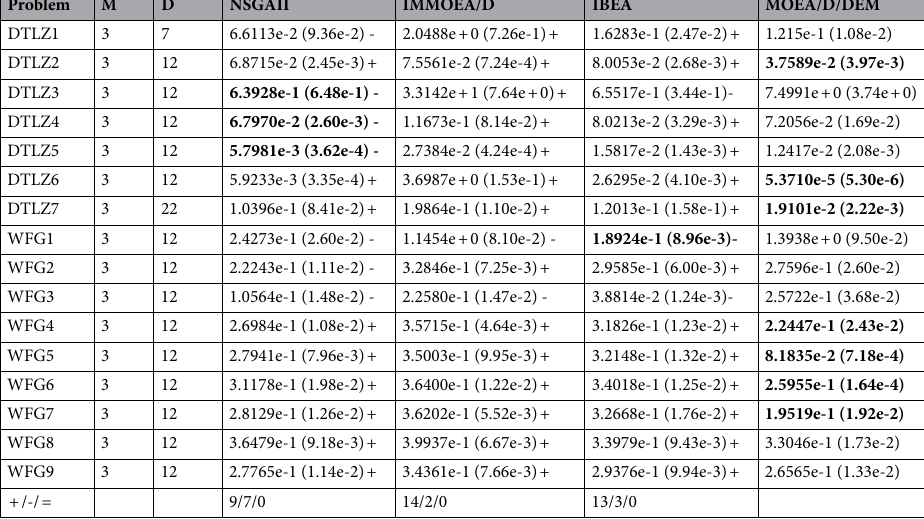
Table 2. IGD values of 7 algorithms in 16 problems. The best of the comparison results are in [bold].